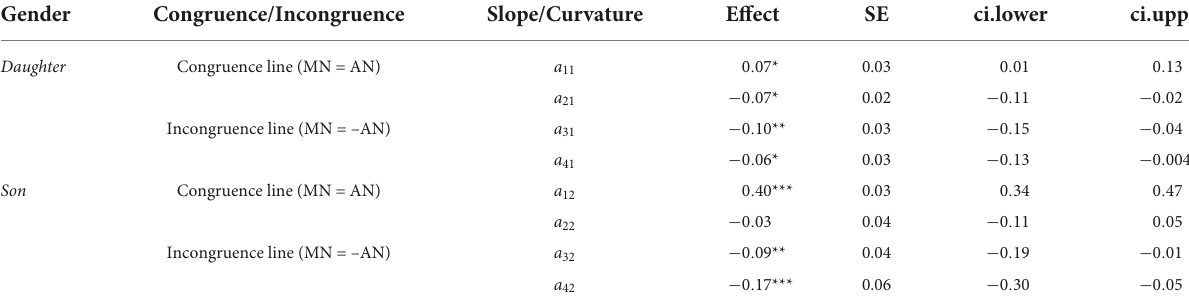
TABLE 3 Gender difference of congruence effect on punitive parenting